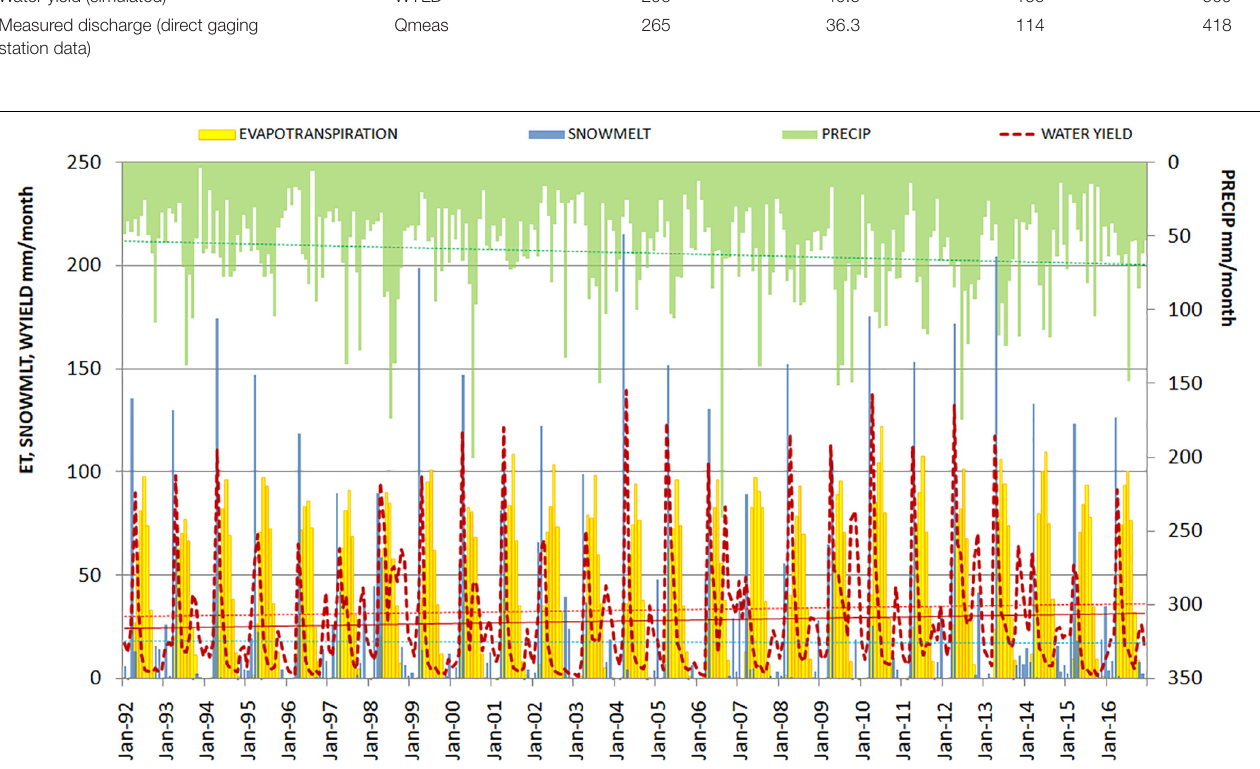
FIGURE 7 | Simulated monthly runoff, snowmelt, evapotranspiration, and measured precipitation sum (reverse scale) for the period of 1992–2016.